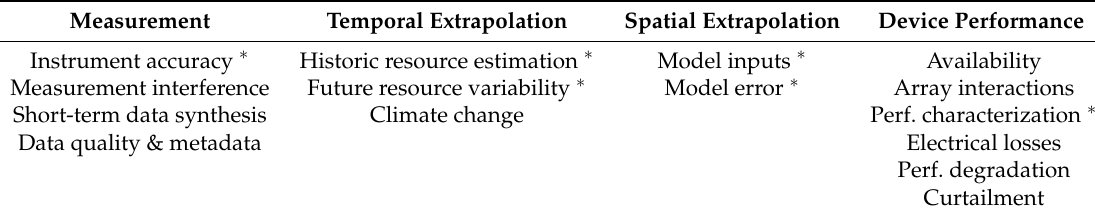
Table 1. Categorization of uncertainty in mean annual energy production estimates for wave energy converters